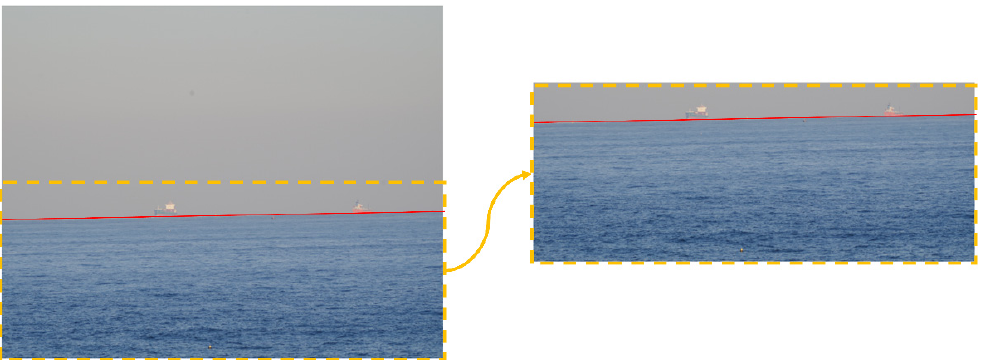
Figure 4. After the sea–sky line is detected, it can be used to effectively reduce the candidate search regions.